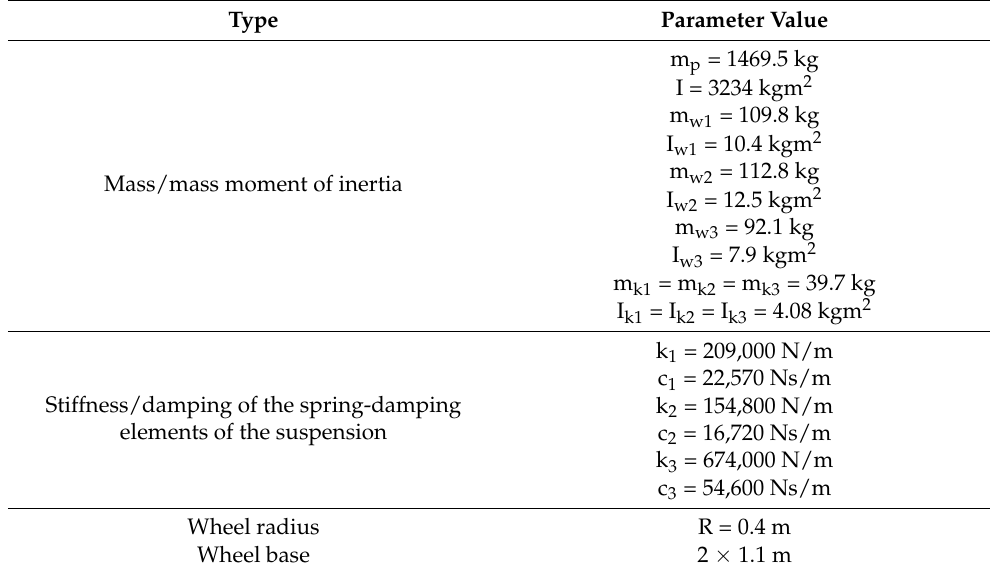
Table 1. Values of main vehicle body parameters [16].